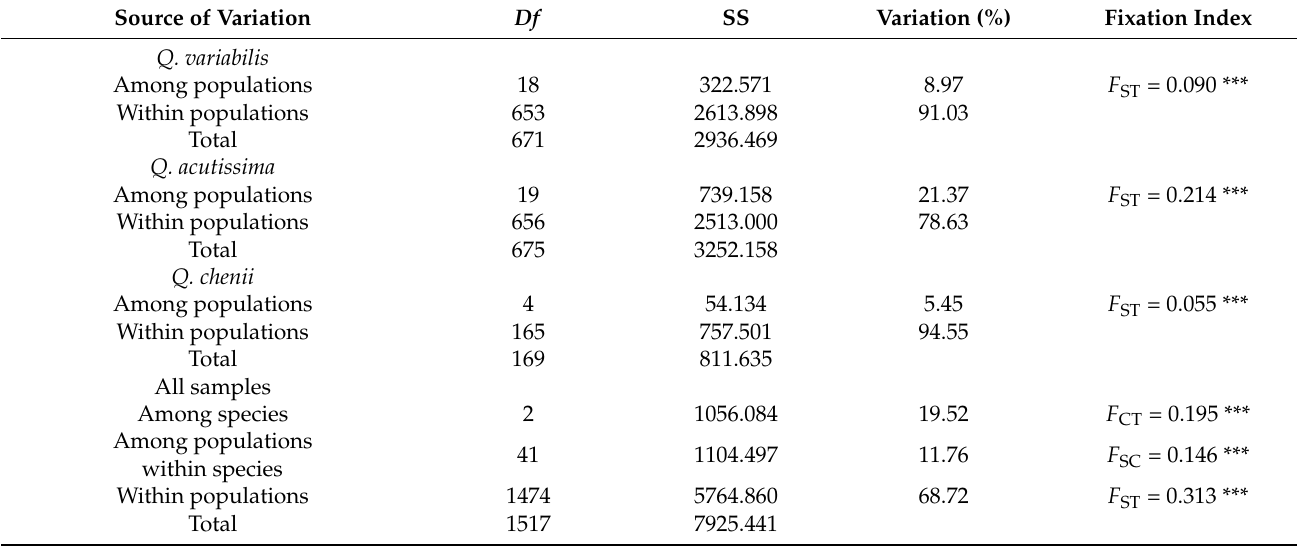
Table 1. Analyses of molecular variance (AMOVA) based on 16 nSSR data for intra and inter-species of the three Cerris oaks. Notes: Df , degrees of freedom; SS, sum of squares; significance levels: *** p < 0.001; 1000 permutations; F CT , divergence